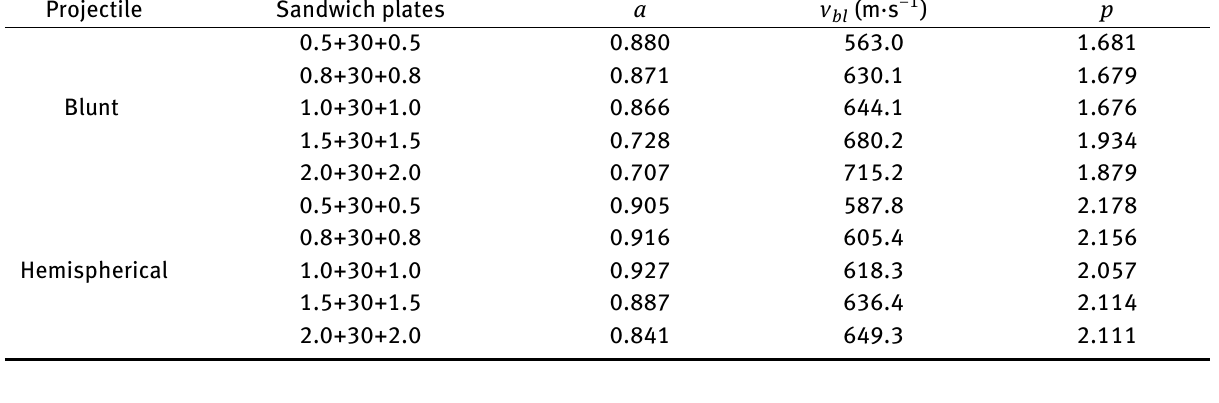
Table 6: Ballistic limits and model constants of sandwich plate with various thicknesses of face-sheets Projectile